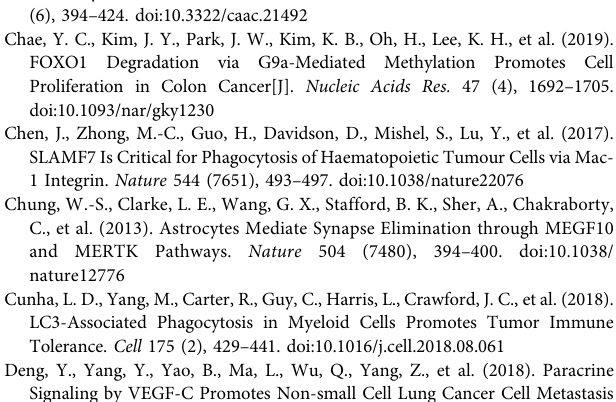
Supplementary Figure 3 | Forest map of 27 prognostic phagocytic factors in PRAD. Supplementary Figure 4 | LASSO analysis. (A) . Forest map of OS model risk values and key genes; (B) . LASSO coef fi cient distribution of prognostic differential genes; (C) . Bar graph of correlation coef fi cients of 7 key genes. Supplementary Figure 5 | Relationship between risk score and effect of immunotherapy in Renal Cell Cancer. (A) . KM curve; (B) . Riskscore distribution of different ef fi cacy groups; (C) . Distribution of different immune ef fi cacy groups in the high and low Riskscore groups; (D) . Riskscore histogram of different ef fi cacy groups; (E) . ROC curves at different times (Renal Cell Cancer). Supplementary Figure 6 | Translational levels of the signature genes in the Human Protein Atlas. (A) . GNE protein expression in cancers; (B) . PDCD10 protein expression in